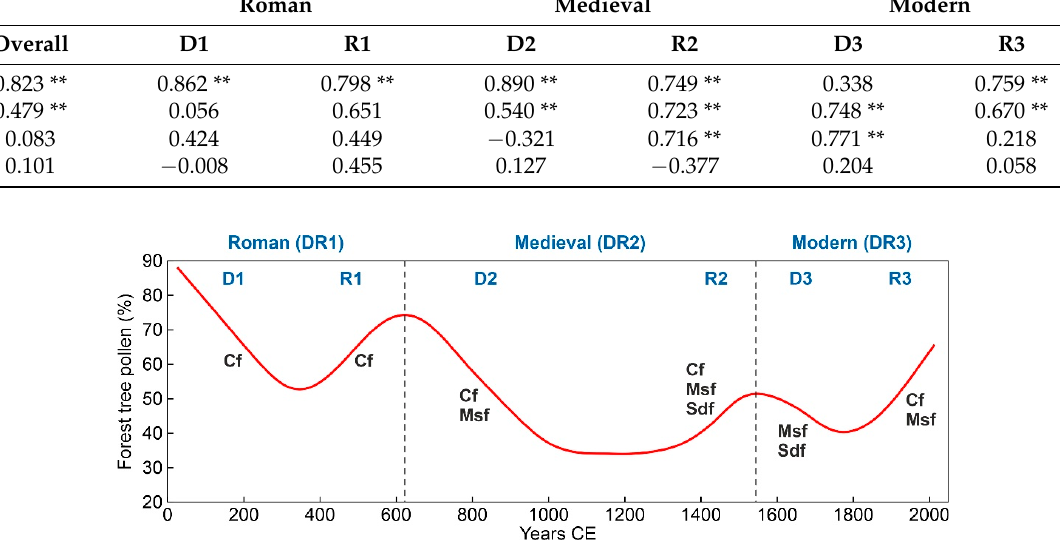
Figure 7. Forest types statistically associated with the general forest trends (red line) for each particular deforestation and regeneration phase, according to the results of the correlation analysis. All correlations were significant at p < 0.01 (Table 2). Cf, conifer forest; Msf, Mediterranean sclerophyll forests; Sdf, submontane deciduous forest.